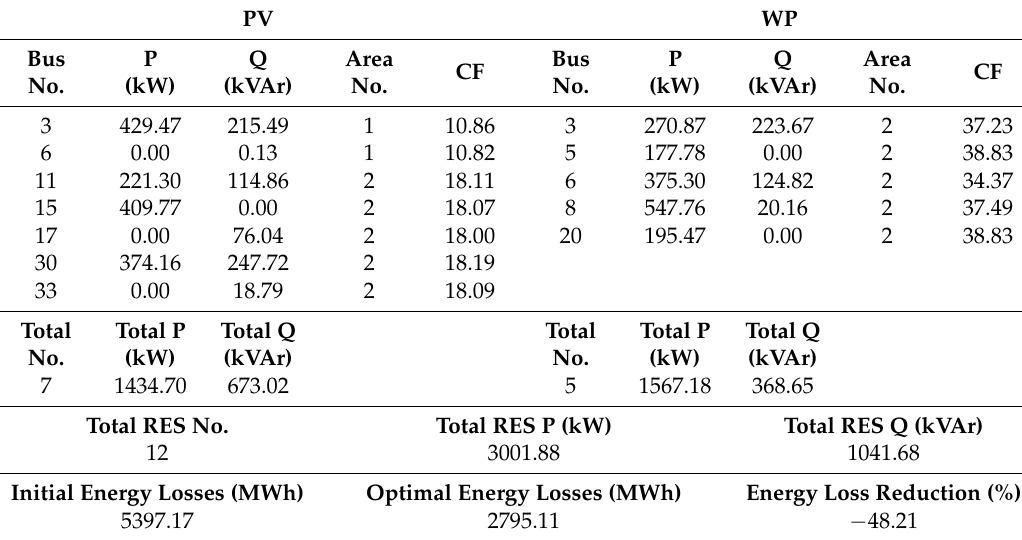
Figure 13. Detailed Analysis—Scenario #1 solution. Table 9. Detailed Analysis—Scenario